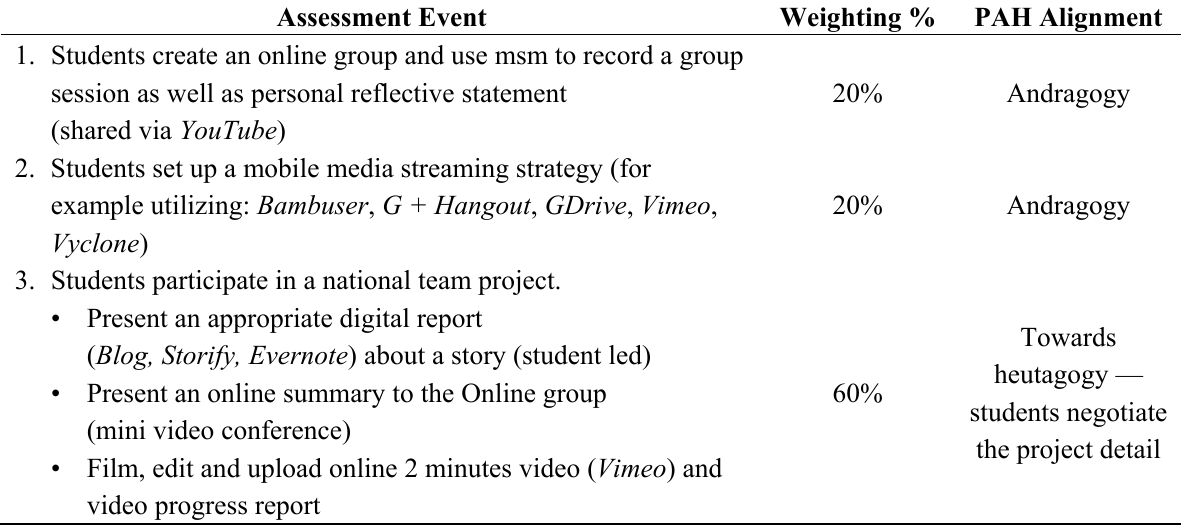
Table 6. Mobile social media collaboration assessment plan.